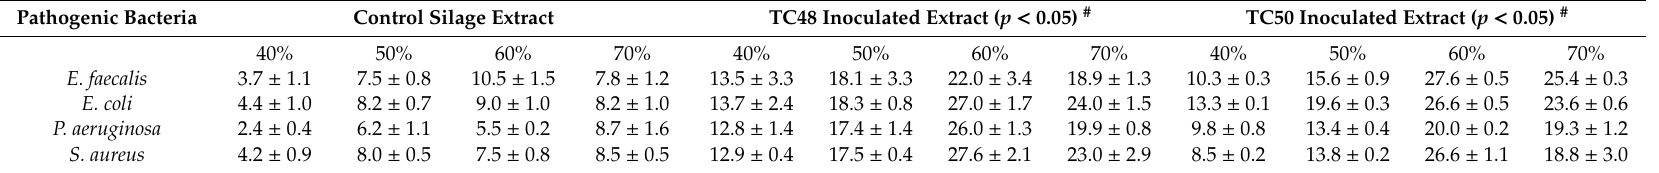
Table 2. Antibacterial activity of silages extract fermented with TC48 and TC50 at di ff erent moistures levels. Pathogenic